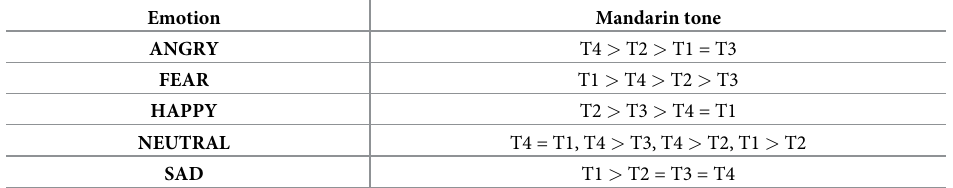
Table 3. Summary of pairwise comparisons for Mandarin tone identification accuracy as a function of emotion. The symbol > indicates a significant difference ( p < .05) and = indicates no significant difference.